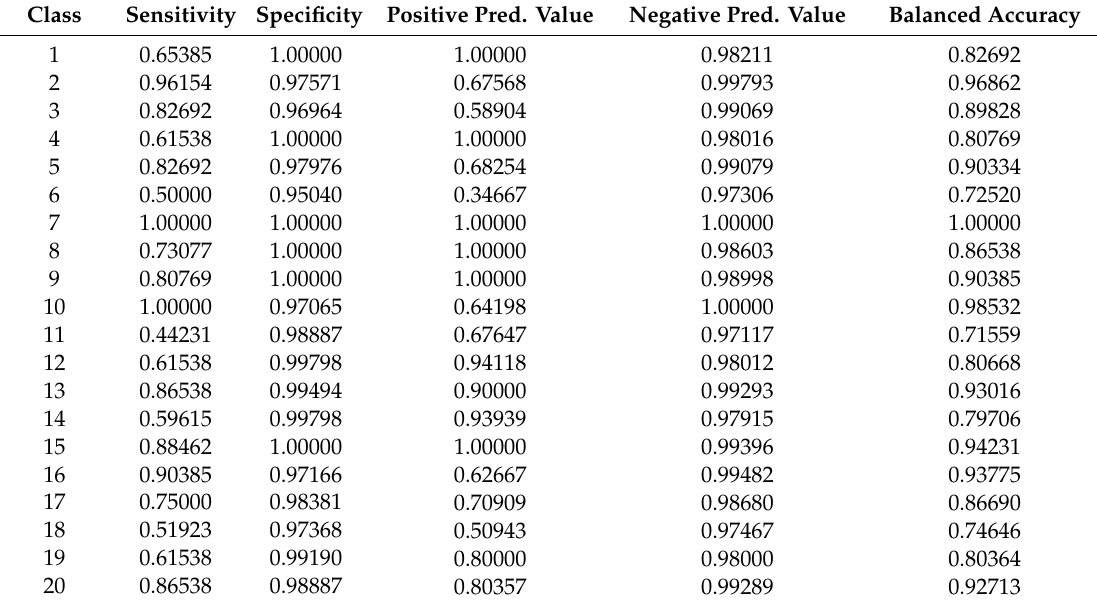
Table 6. Statistics by